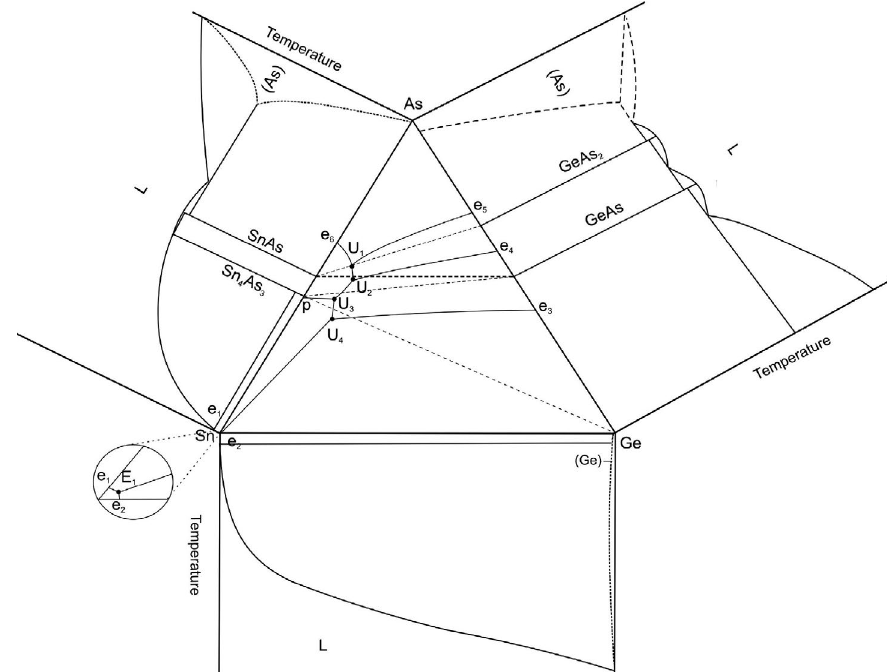
Figure 13. Sn–As–Ge phase diagram.